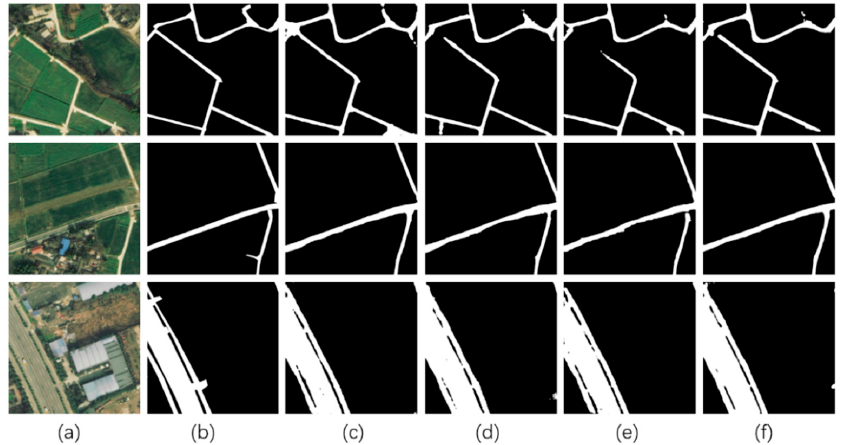
Figure 19. Low-grade road extraction in simple scene images ( a ) input image; ( b ) label image; ( c ) D-LinkNet; ( d ) S-DenseNet; ( e ) SD-DenseNet; ( f ) SDG-DenseNet.